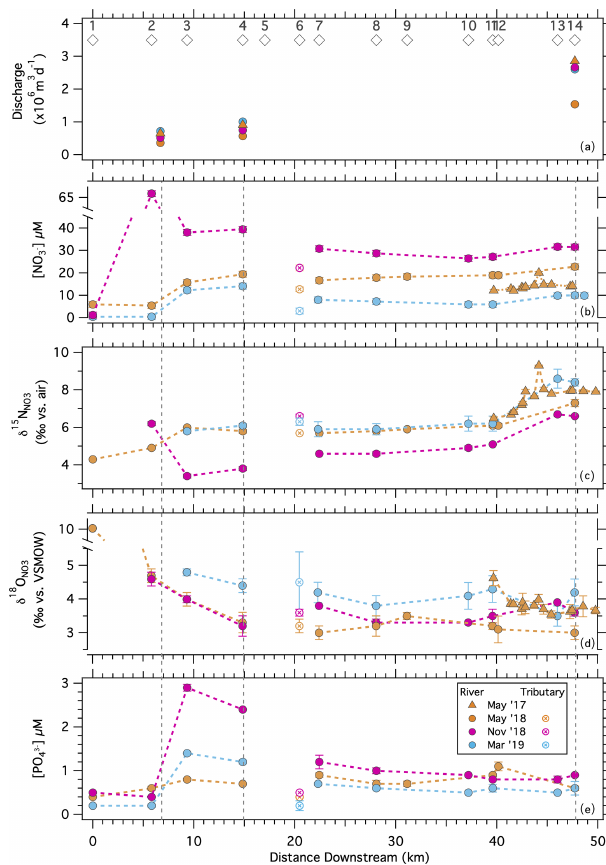
Figure 6. Solute concentrations and nitrate isotopologue ratios ob- served along the Pawcatuck River from its origin at Worden Pond to the Westerly Bridge during along-river sampling